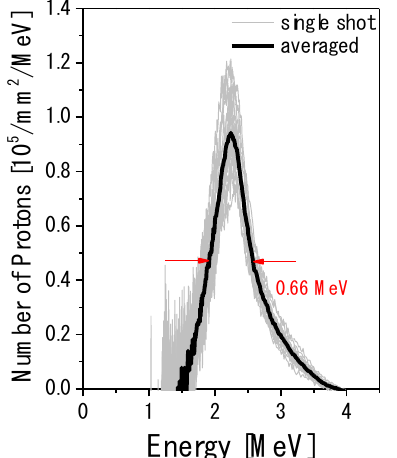
Figure 21. Energy spectra of protons monitored by the Time-of-Flight (TOF) spectrometer.